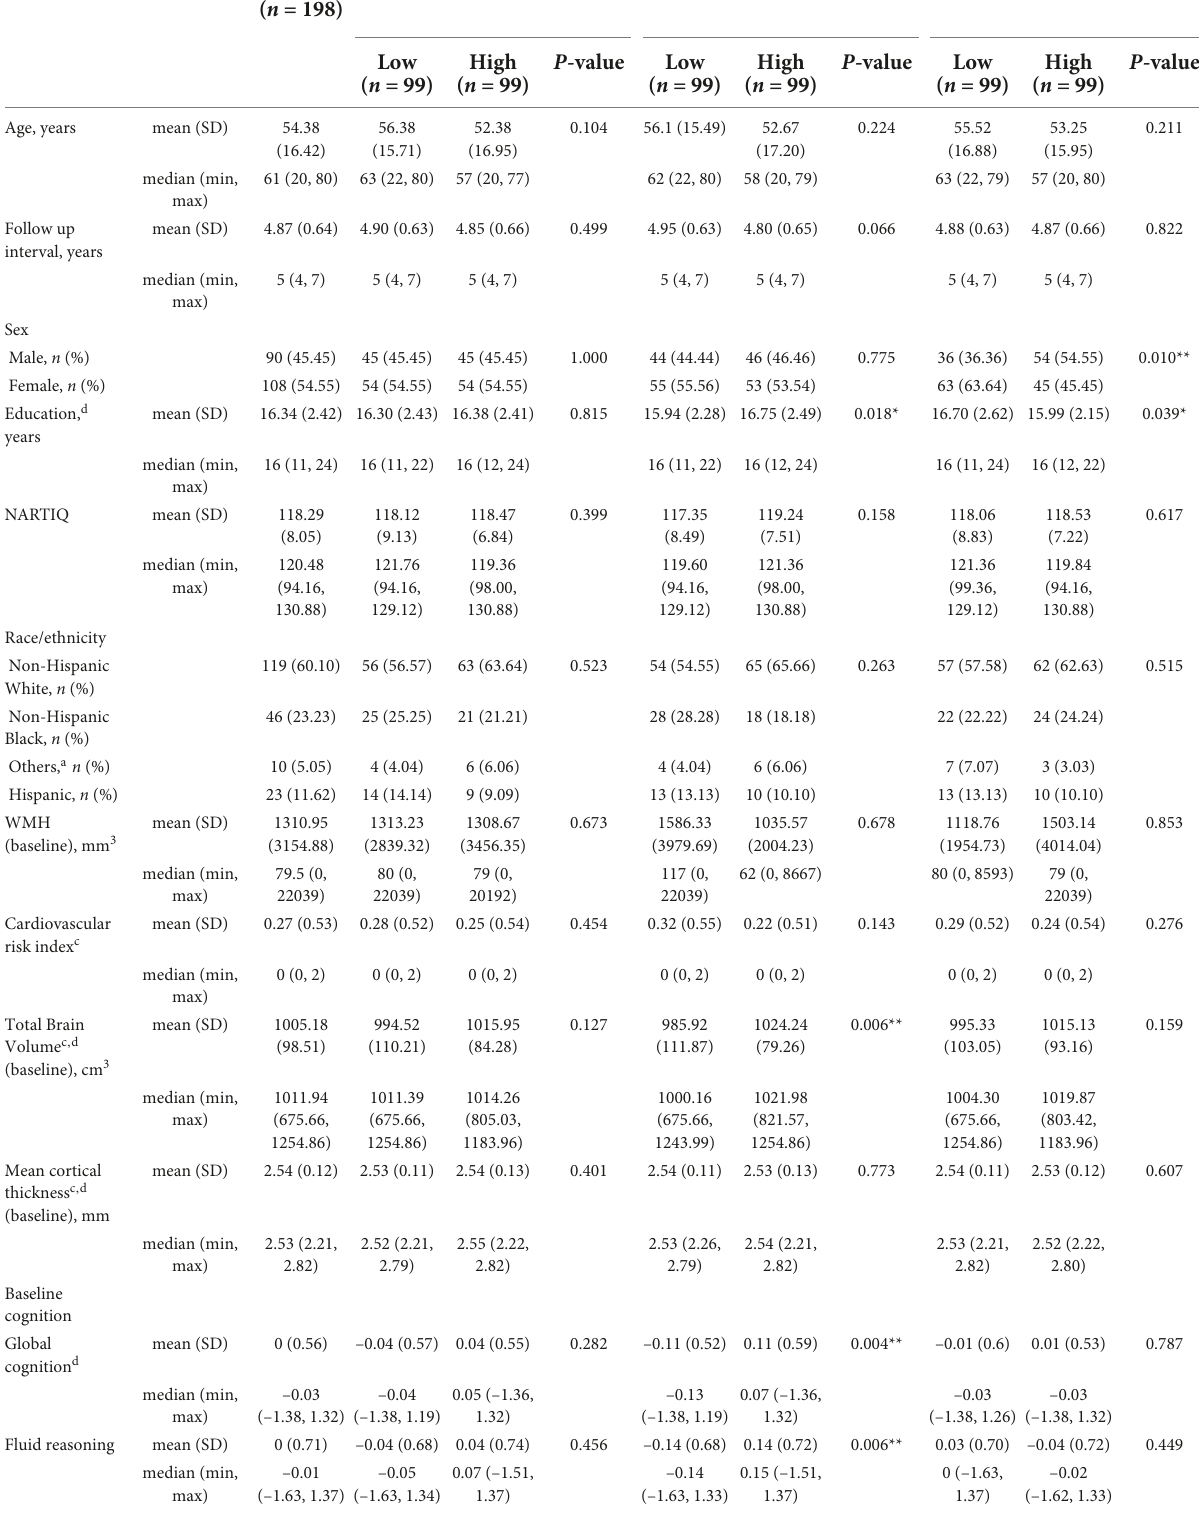
TABLE 2 Summary of characteristics of study participants ( n =